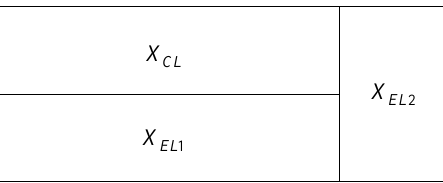
Figure 3. The receiver structure with the successive interference cancellation (SIC) detector of the LDM-Ex-FDM scheme.